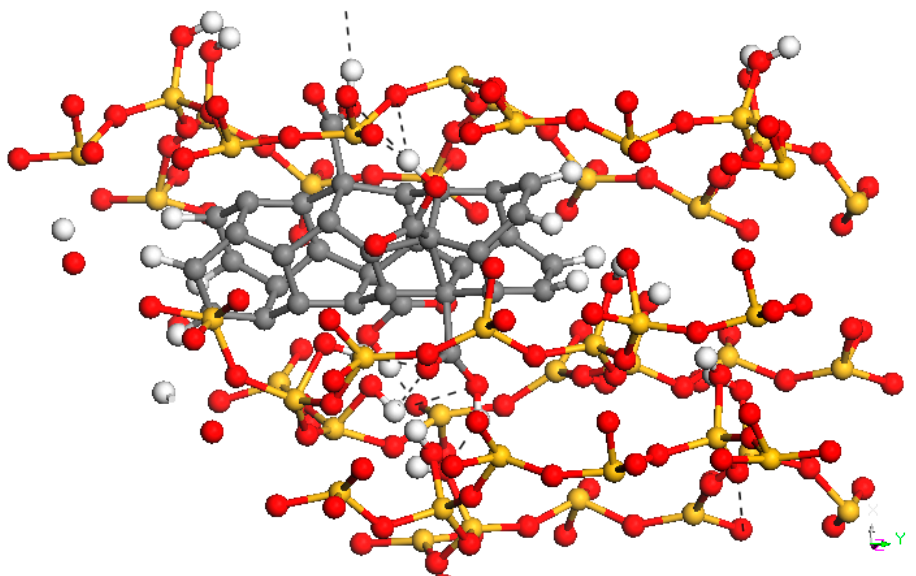
Figure 5. H bonds (black dash lines) between the tobermorite and a CNT functionalized with 4 COOH groups. Red: oxygen, Yellow: silicon, White: hydrogen, Grey: carbon.